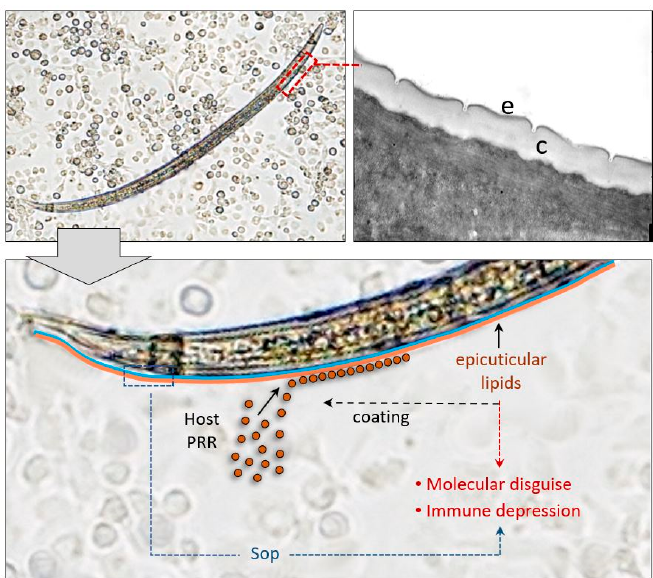
Figure 8. The body surface of Steinernema spp. interacts with hemolymph components through specific adhesion; this interaction leads to the removal of key factors fundamental for triggering the insect immune processes (as observed in S. feltiae ); moreover, the hemolymphatic proteins attached to the epicuticle covering the nematode are not recognized by the host hemocytes (as observed in S. feltiae and S. carpocapsae